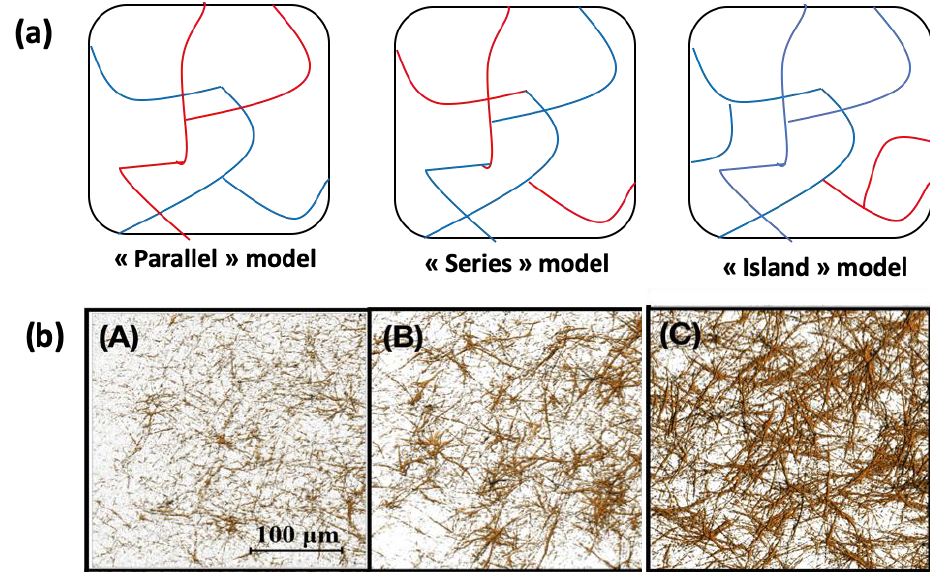
Figure 5. ( a ) Schematic representation of the possible structure of mixed type I collagen-fibrin gels; ( b ) second harmonic generation images of the collagen network in mixed gels with increasing collagen content from ( A ) to ( C ). In ( C ) collagen is not homogeneously dispersed in the network, in favor of the “Island” model. ( b ) is adapted and reproduced with permission from [143]. Copyright 2018 Acta Materialia Inc.